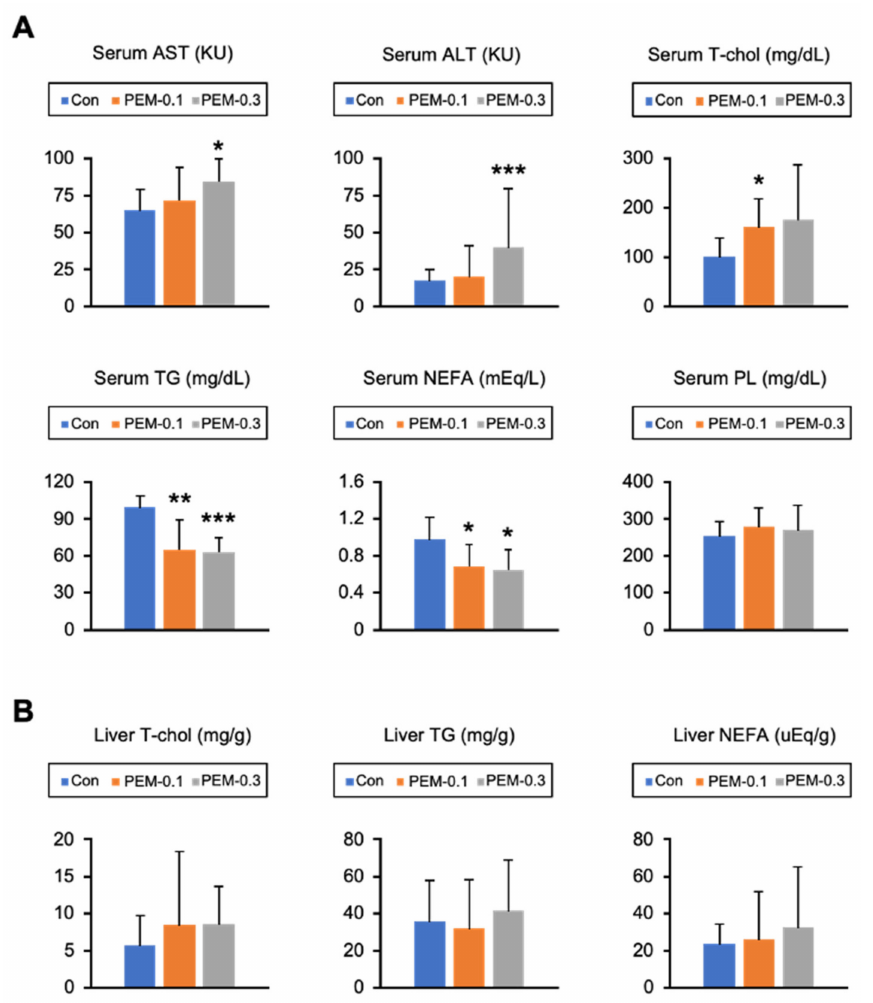
Figure 2. Clinically relevant dose of PEM reduces serum TG and NEFA. ( A ) Serum aspartate aminotransferase (AST) and alanine aminotransferase (ALT) activities and serum total cholesterol (T-Chol), triglyceride (TG), non-esterified fatty acid (NEFA), and phospholipid (PL) levels. ( B ) Hepatic content of T-Chol, TG, and NEFA. Data are expressed as the mean ± SD. * p < 0.05, ** p < 0.01, and *** p < 0.001 vs. control group. Con, vehicle-treated mice; PEM-0.1, pemafibrate-treated mice at a clinically relevant dose (0.1 mg/kg/day); PEM-0.3, pemafibrate-treated mice at a relatively high dose (0.3